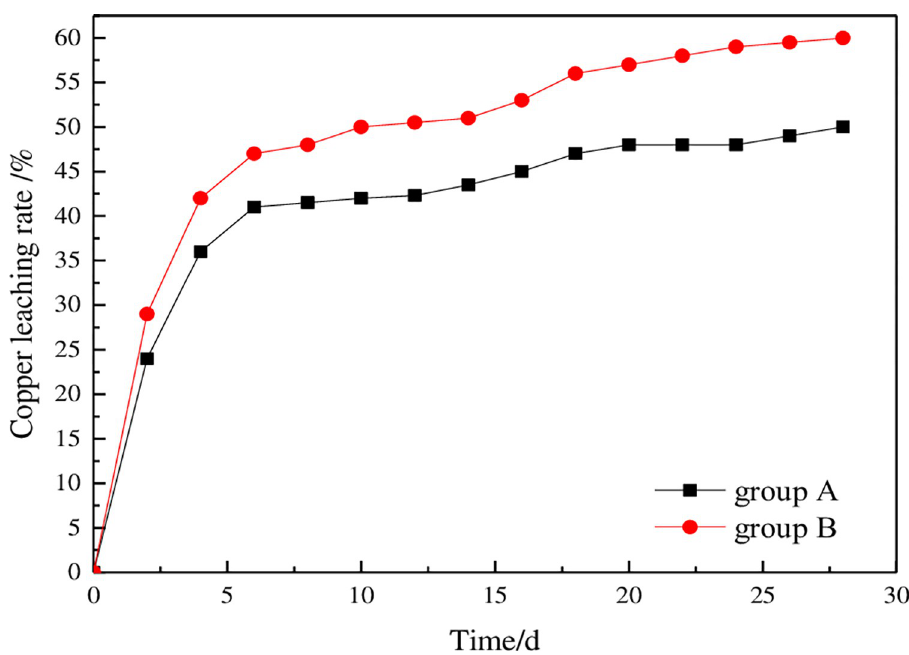
Fig 11. Change curves for copper leaching rates in the column leaching